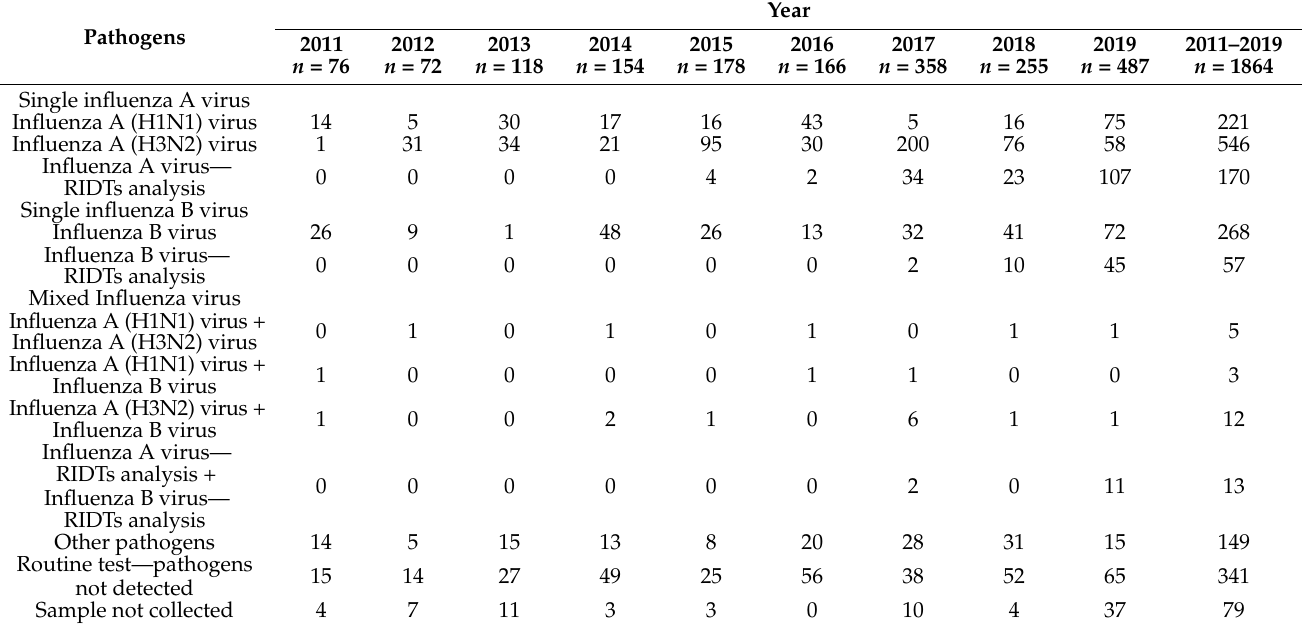
Table 1. The characteristics of influenza virus and other pathogens by analyzed URTI cluster data from 2011 to 2019,